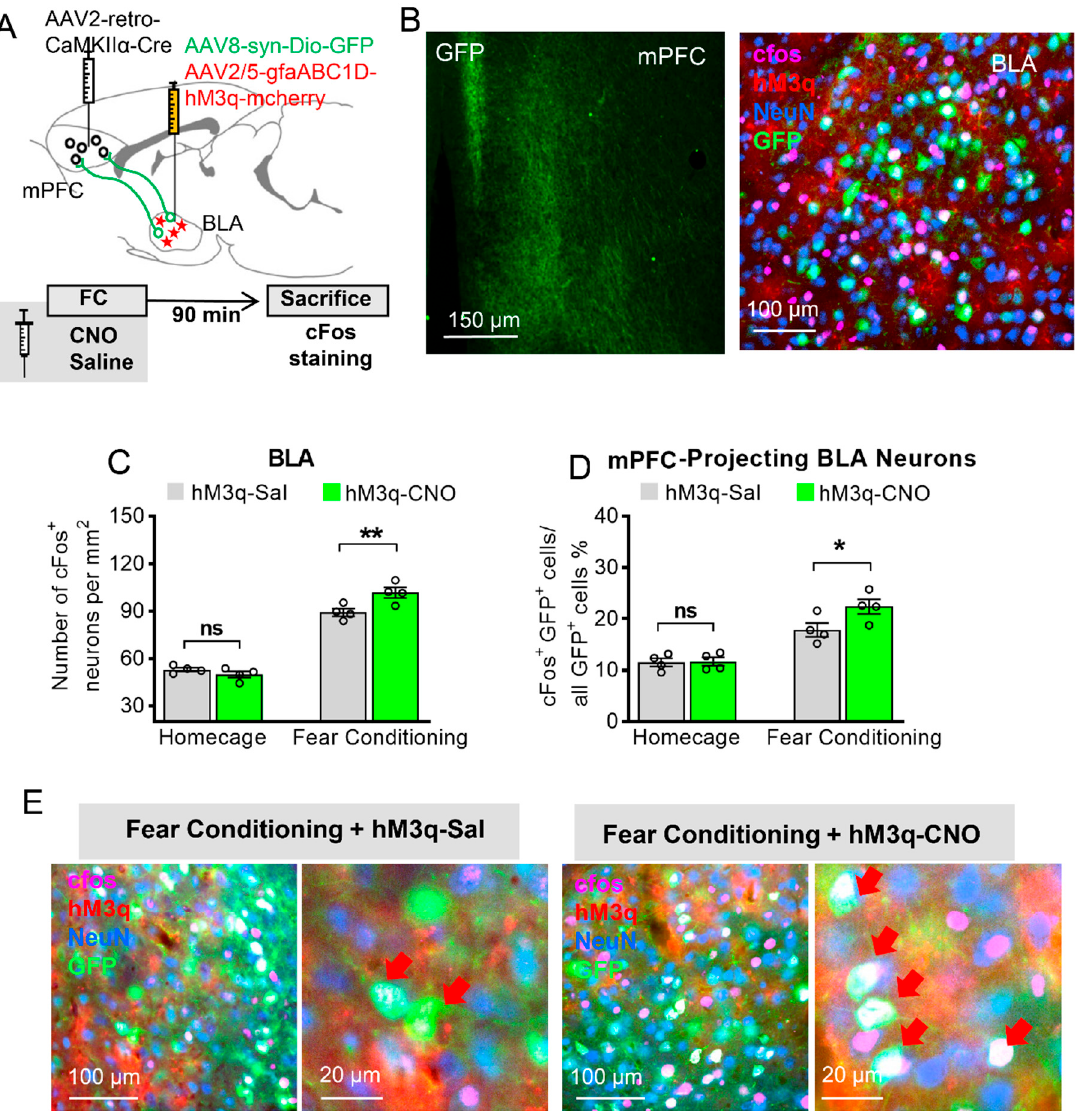
Figure 3. Astrocytic Gq modulation induces a projection-specific enhancement of BLA–mPFC neurons during fear learning. ( A ) Schematic diagram of targeting mPFC-projecting BLA neurons: AAV2-retro-CamkII-Cre was injected into the mPFC, and AAV8-syn-Dio–GFP together with AAV2/5-gfaABC1D-hM3q-mcherry was injected into the BLA. ( B ) Left: GFP-positive axons of BLA projection neurons are clearly visible in the mPFC. Right: mPFC-projecting BLA neurons (green) with c-Fos (pink) and NeuN (blue) staining, and hM3q (red) in BLA astrocytes. ( C ) c-Fos level in BLA neurons of four-group mice expressing GFP in mPFC-projecting BLA neurons and hM3q in their BLA astrocytes ( n = 4 of each group, 5 slices for each mouse, two-way ANOVA with Bonferroni post hoc comparison test, main effect of Sal/CNO: F (1, 6) = 6.423, p = 0.0444, ‘homecage (HC) + hM3q-Sal’ versus ‘HC + hM3q-CNO’: p > 0.9999, ‘fear conditioning (FC) + hM3q-Sal’ versus ‘FC + hM3q-CNO’: p = 0.0055, ** stands for p < 0.01, ns stands for no significance). ( D ) Fear-conditioned mice injected with CNO showed increase in the percentage of mPFC-projecting BLA neurons that express c-Fos compared with FC mice injected with saline ( n = 4 of each group, two-way ANOVA with Bonferroni post hoc comparison test, main effect of Sal/CNO: F (1, 6) = 7.424, p = 0.0344, ‘HC + hM3q-Sal’ versus ‘HC + hM3q-CNO’: p > 0.9999, ‘FC + hM3q-Sal’ versus ‘FC + hM3q-CNO’: p = 0.032, * stands for p < 0.05, ns stands for no significance). ( E ) Representative images of hM3q (red), c-Fos (pink), mPFC-projecting BLA neurons (green), and NeuN (Blue) in the BLA; red arrow shows the mPFC-projecting BLA neurons with c-Fos expression. All data are presented as mean ± SEM.